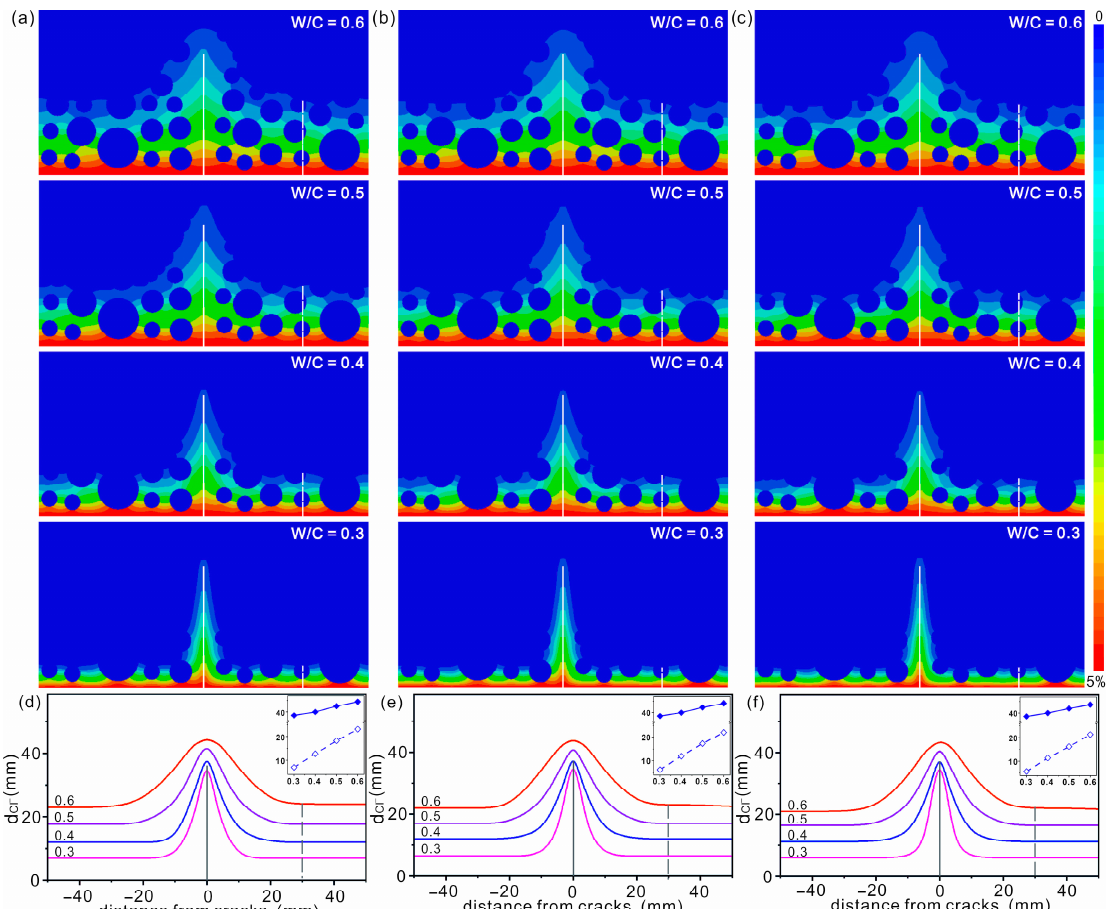
Figure 7. Di ff usion cloud maps ( a–c ) and the outermost di ff usion contours ( d–f ) (left to right) of chloride in concrete with hydration degrees of 0.8, 0.85 and 0.9, respectively. AC is shown as a solid white/black line. The other position where di ff usion data was collected is highlighted with a dashed line. The chloride di ff usion depths versus di ff erent W/C ratios with x = 0 mm (solid) and x = 30 mm (hollow) are shown as inset.